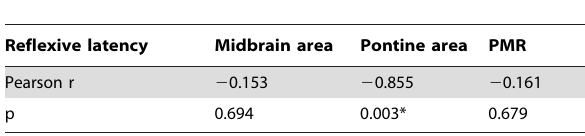
Table 4. Correlations of reflexive latency with brainstem